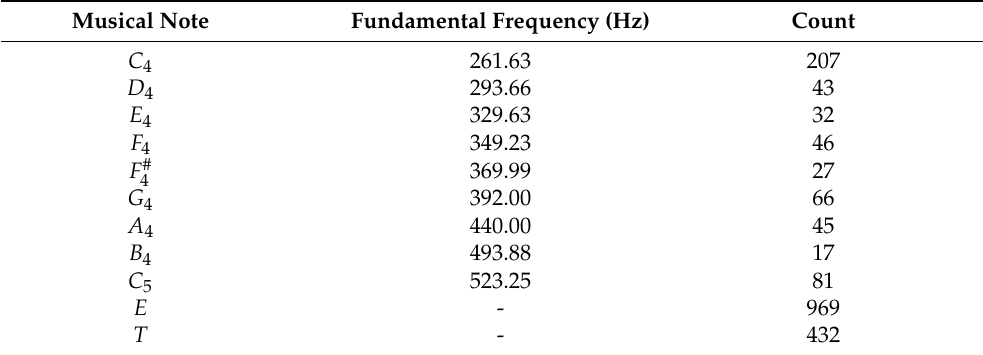
Table 2. Class labels including the Musical Notes in International Organization for Standardiza- tion/International Electrotechnical Commission (ISO/IEC) 60601-1-8 Alarm and their count [ E stands for the Empty class and T stands for the Transition